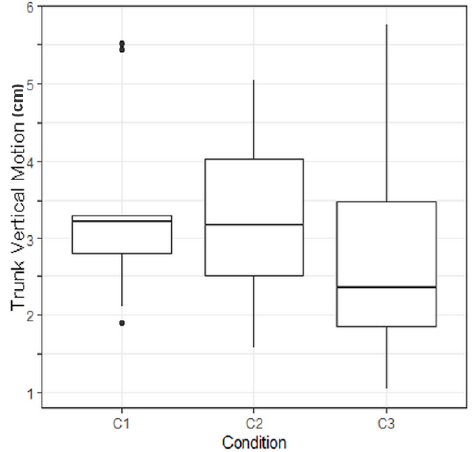
Figure 8. Boxplot illustrating the trunk vertical motion depending on the protocol condition. C1: no assistance, C2: with knee orhosis, C3: with electrical stimulation. C3 led to a significant reduction of the trunk vertical motion.